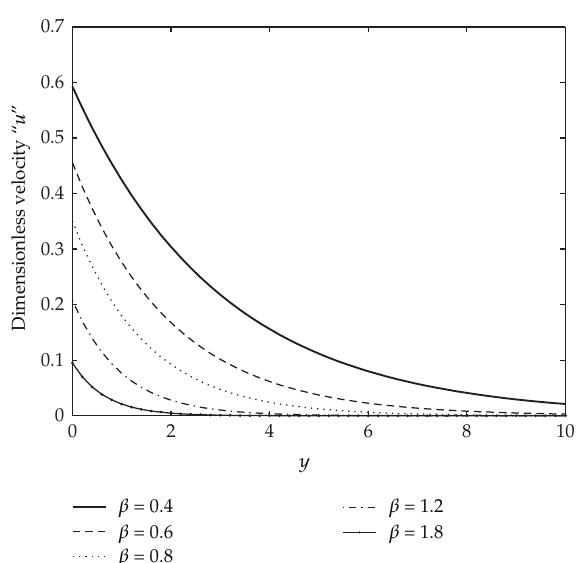
Figure 3: Backward wave-front type travelling wave solution (cid:3) 4.12 (cid:4) varying β when γ (cid:8) 0 . 2, c (cid:8) 1, and t (cid:8) π/ 2 are